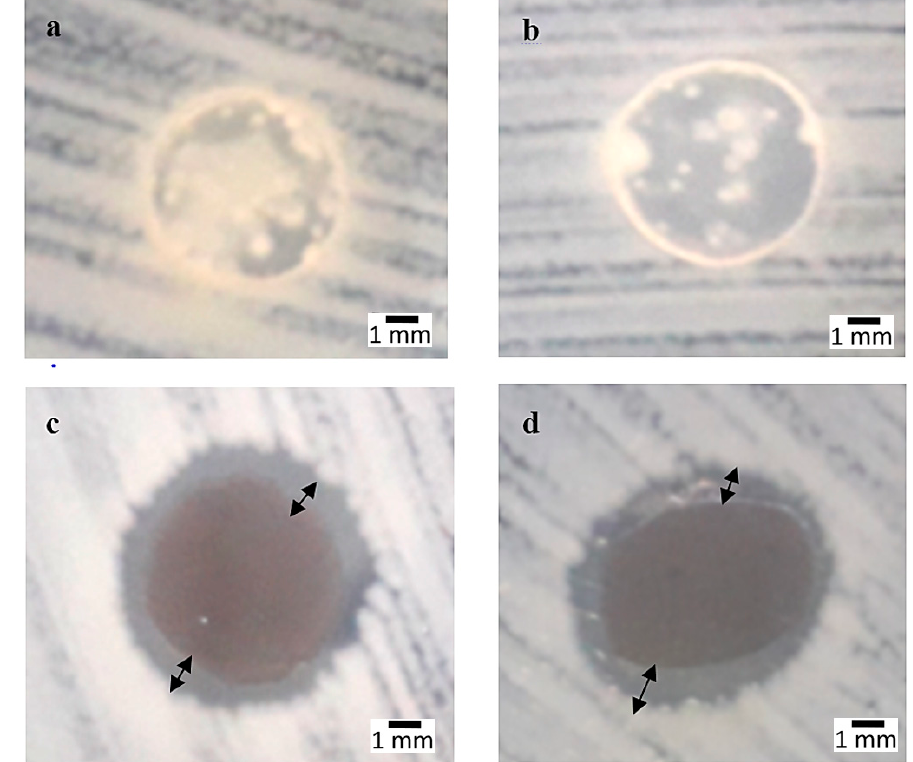
Figure 1. Escherichia coli strain: ( a ) Sugar palm starch (SPS), ( b ) 0 wt%, ( c ) 3 wt%, ( d ) 4 wt% compositions.